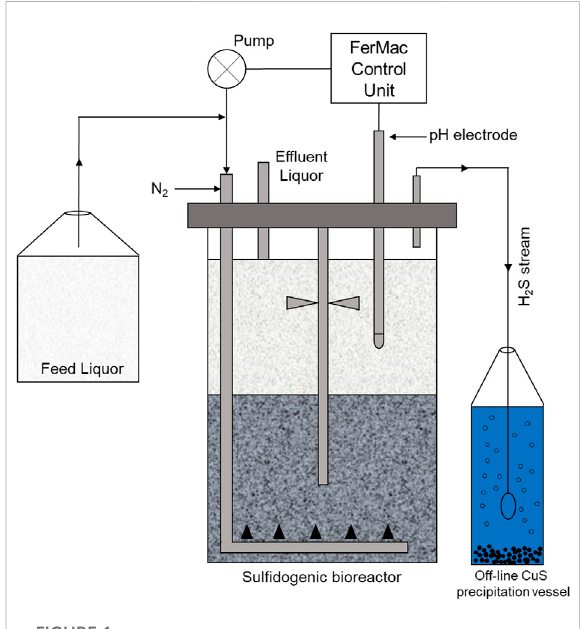
FIGURE 1 Schematic representation of the low pH sul fi dogenic bioreactor. The arrows indicate the direction of liquid/gas fl ow Santos and Johnson